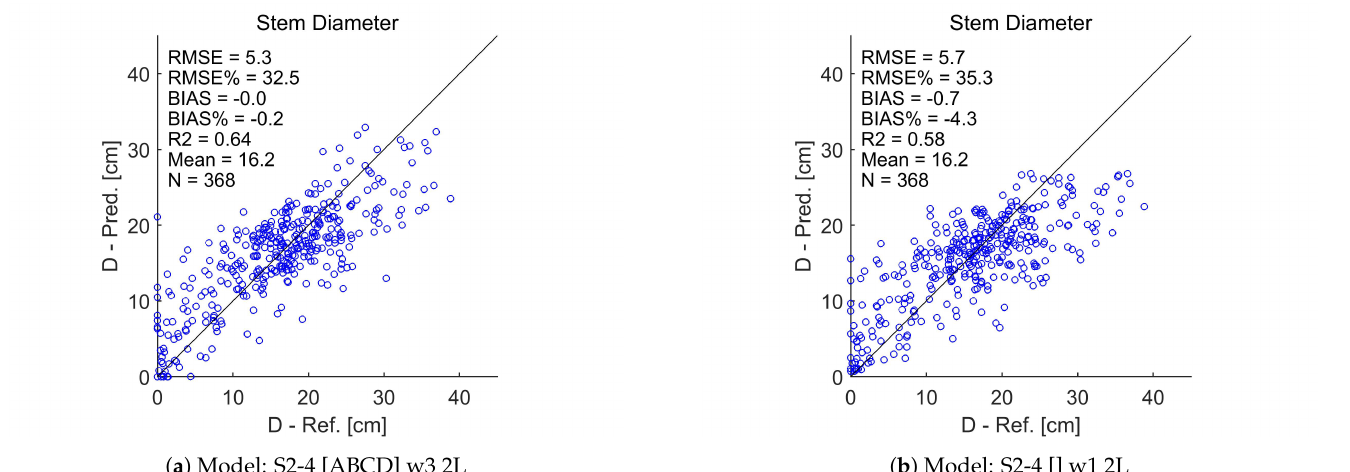
Figure A2. Scatterplots of stem diameter (D) test data set predictions with the proposed model concept ( a ) and with the simple model ( b ).